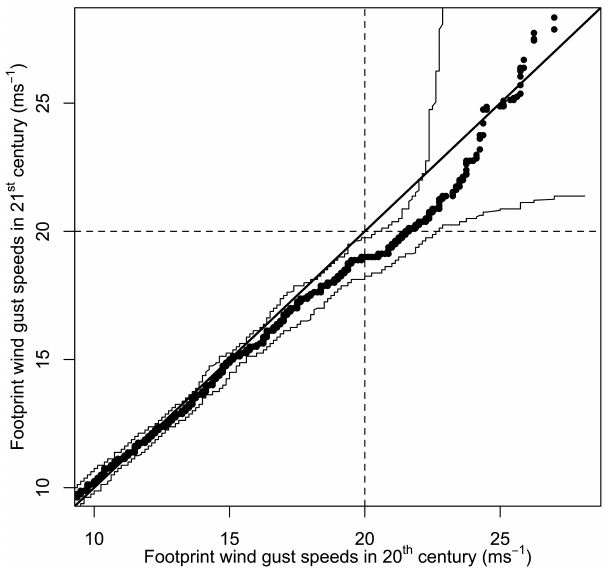
Figure 5. Quantile-quantile plot of footprint wind gust speeds in the grid cell closest to Paris for events in the two comparative periods: winters in the 20th century (1979/1980–1999/2000) and winters in the 21st century (2000/2001–2013/2014). The thick solid black line shows where y = x , the dashed black lines show the 20ms − 1 dam- age threshold and the thin solid black lines show the 95% confi- dence interval, based on the asymptotic sampling distribution of the order